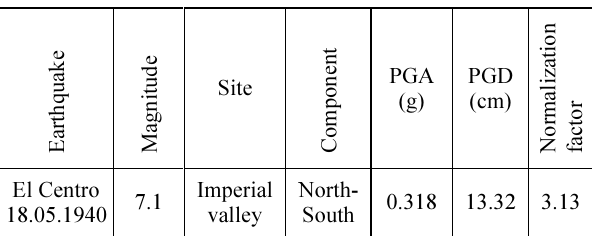
Table 3. El-Centro earthquake characteristics